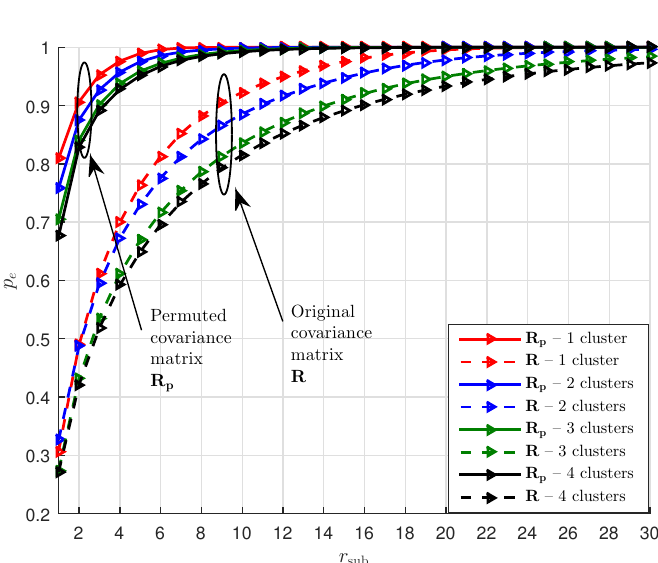
Figure 2. Energy captured by a rank- r sub approximation of R p and R